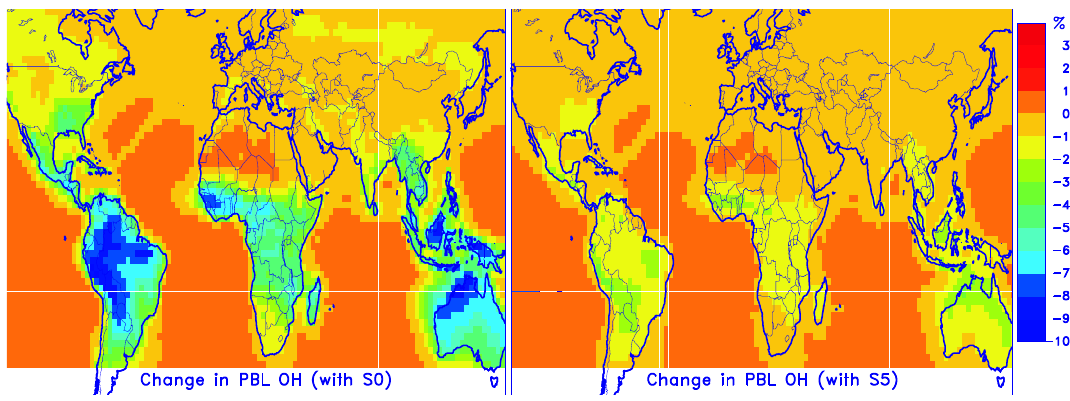
Fig. 6. Sensitivity of OH concentration to a 10% decrease of isoprene emissions using either the MIM2 mechanism (S0) or the LIM0 mechanism